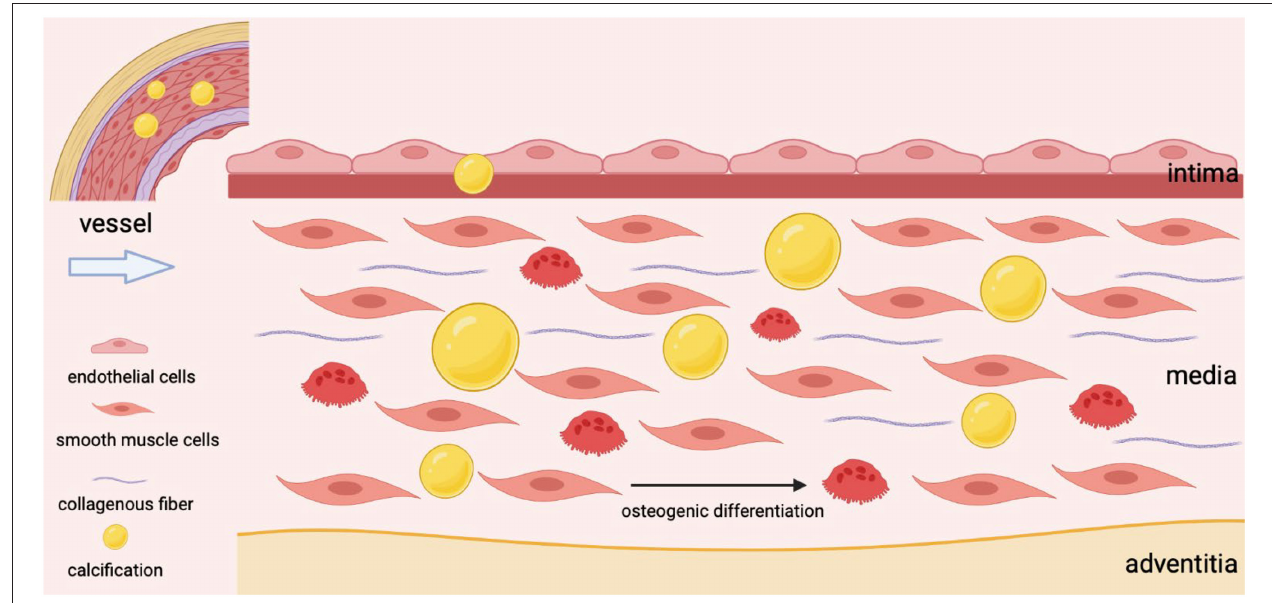
FIGURE 1 | The osteogenic differentiation of VSMCs during vascular